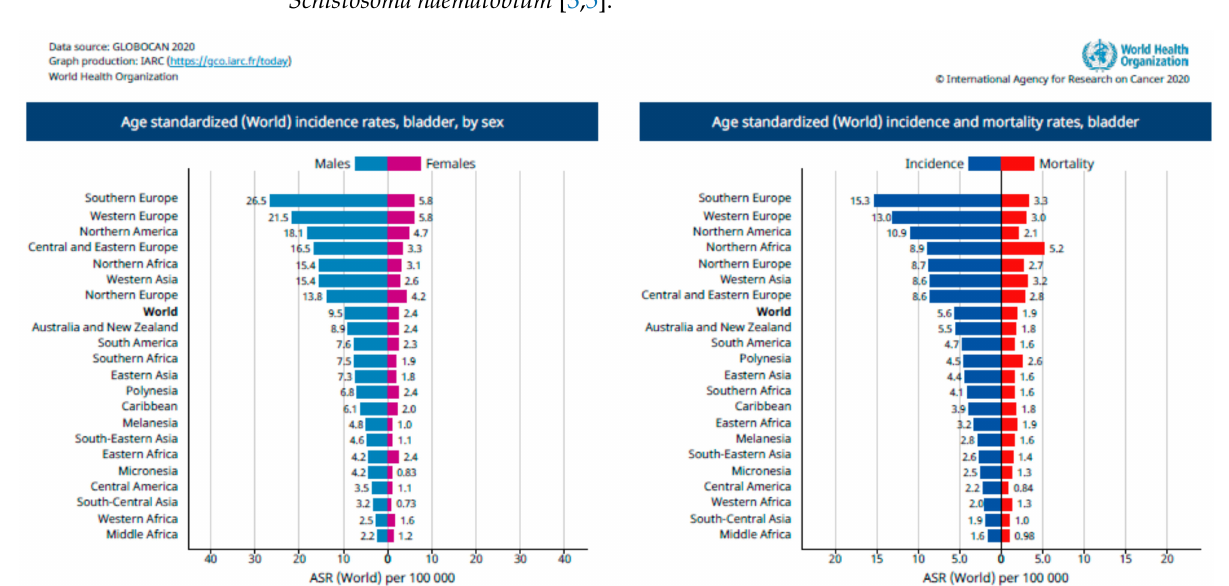
Figure 1. Age-standardized incidence rates of bladder cancer in the world according to the World Health Organization. Reprinted from Bladder Cancer, The Global Cancer Observatory, Copyright (2020)